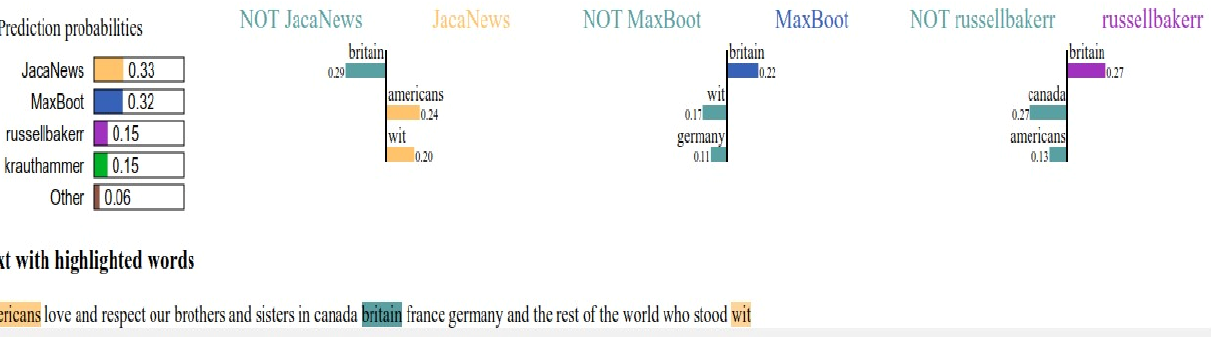
Figure 8. Explanation of individual prediction of the proposed method on the IMDB62 document using LIME.